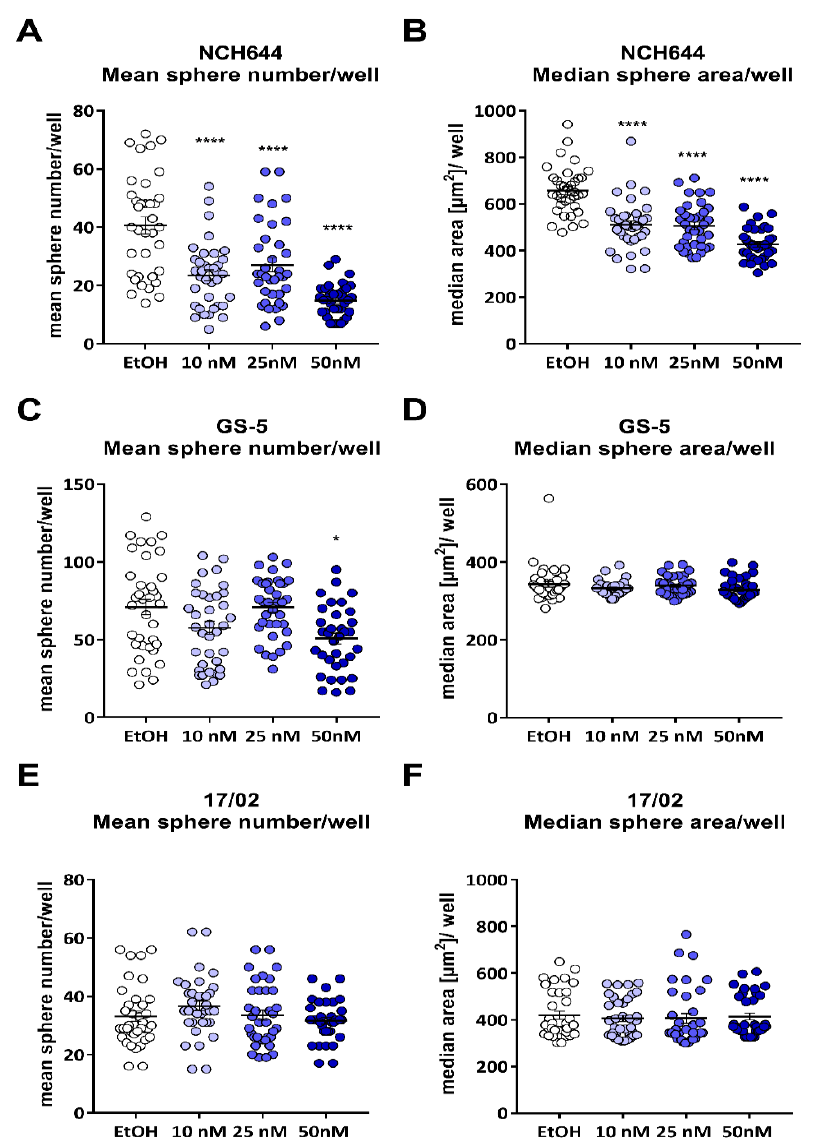
Figure 3. Calcitriol reduces sphere number and sizes of NCH644 and, to a lesser extent, in GS-5 GSCs: ( A , B ) Point-plots of NCH644 GSCs 7 days after treatment with solvent (ethanol, EtOH), 10 nM of calcitriol (Cal, light blue), 25 nM of Cal (blue) or 50 nM of Cal (dark blue) after seeding of 512 cells after analyses using a self-made FIJI-macro to measure ( A ) sphere number, ( B ) median sphere size. ( C , D ) Point-plots of GS-5 GSCs 7 days after seeding of 1024 and treatment as in ( A ). ( E , F ) Point-plots of 17/02 primary GSCs 7 days after seeding of 512 cells as in ( A ). * p < 0.05; **** p < 0.0001; one-way ANOVA Dunnett’s multiple comparisons test.